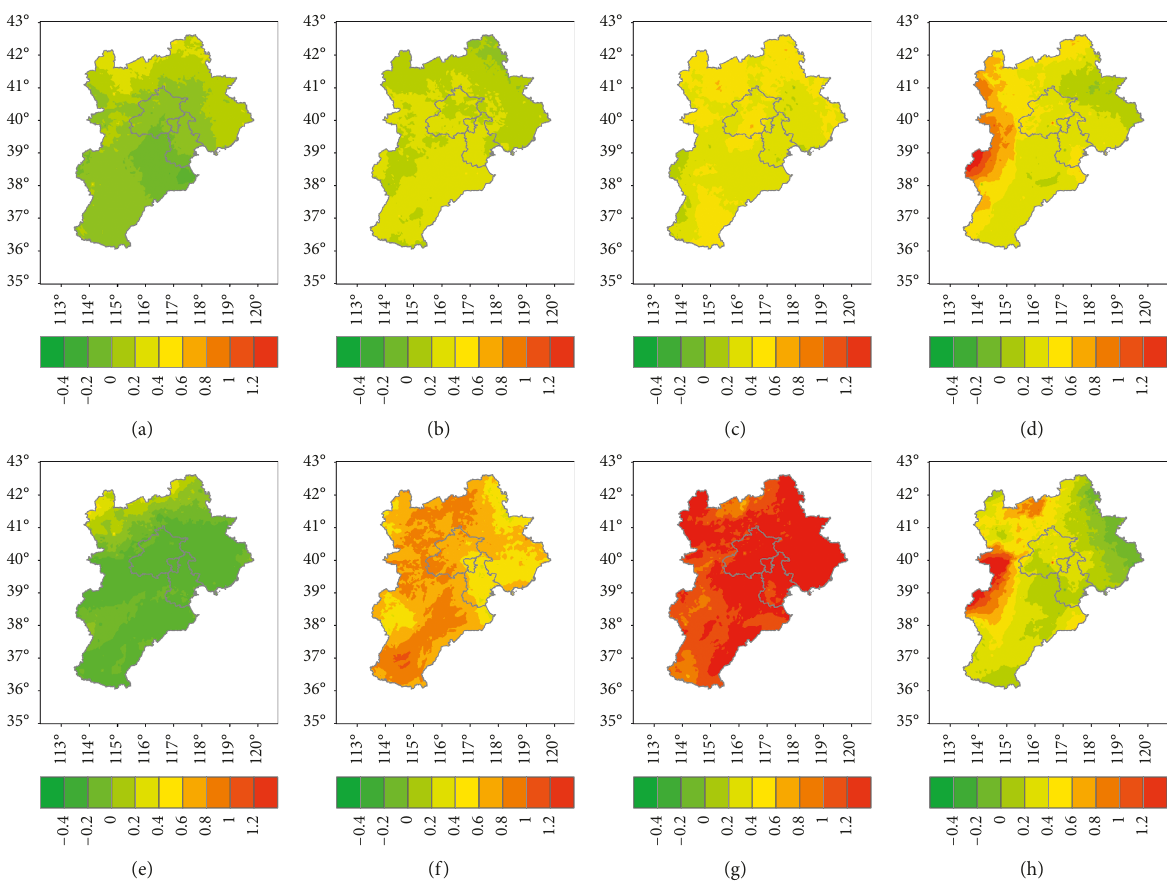
Figure 8: Interdecadal variations in mean temperature in autumn and winter over the Beijing-Tianjin-Hebei region: (a) autumn T2-T1; (b) autumn T3-T2; (c) autumn T4-T3; (d) autumn T5-T4; (e) winter T2-T1; (f) winter T3-T2; (g) winter T4-T3; (h) winter